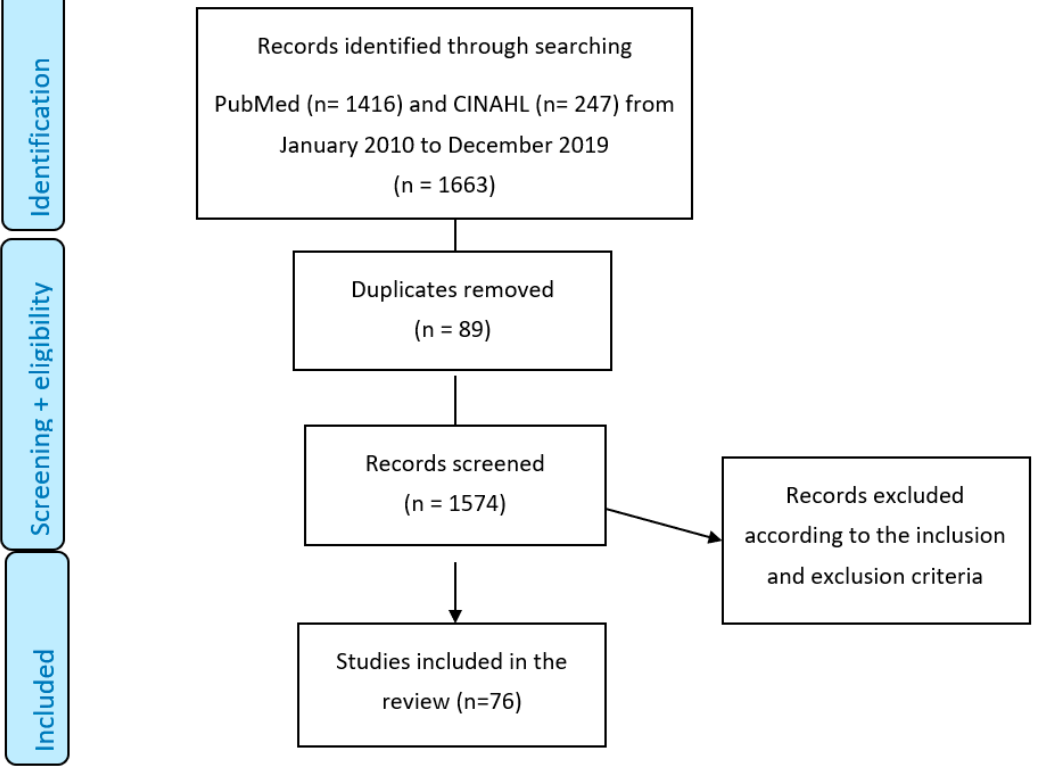
Figure 1. PRISMA flow diagram.